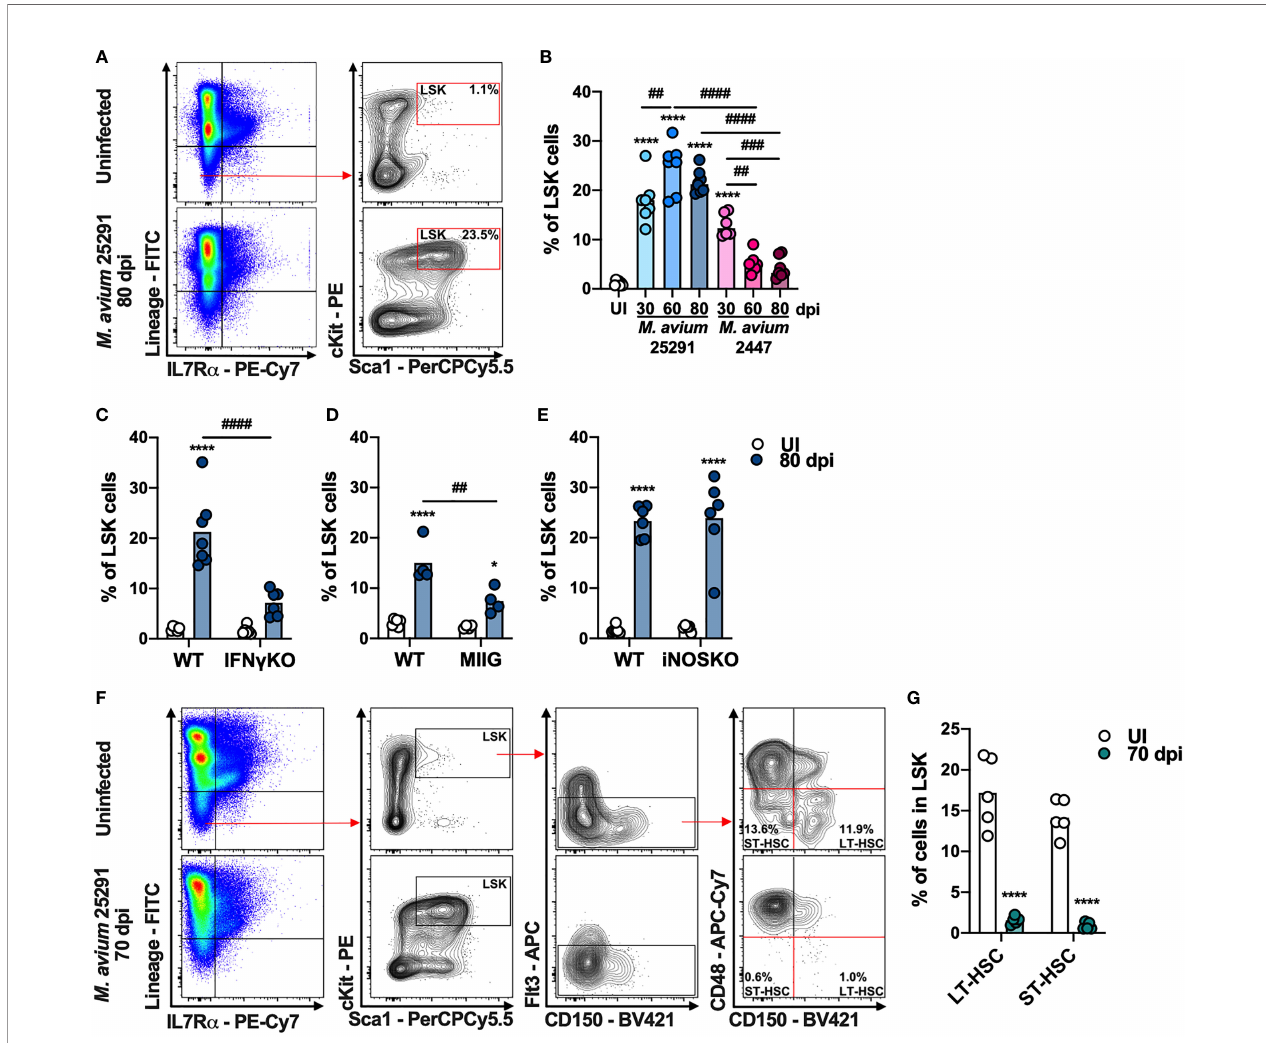
FIGURE 2 | Mice infected with M. avium strain 25291 have higher percentage of LSK cells in an IFN g -dependent and iNOS-independent manner. (A) Schematic representation of the gating used to identify LSK cell population in the BM from uninfected WT mice (top), or infected for 80 days with M. avium 25291 (bottom). Total BM cells were previously selected eliminating doublets and debris. (B) Percentage of LSK cells from uninfected WT mice (white) or after infection with M. avium strain 25291 (blue) or strain 2447 (pink) at 30, 60 and 80 dpi. Comparisons between infected and uninfected mice were performed using ordinary one-way ANOVA followed by Dunnett ’ s multiple comparisons test, and marked as: **** p < 0.0001; comparisons between all the infected groups were performed using a 2-way ANOVA followed by Tukey ’ s multiple comparisons test, and marked as: ## p < 0.01, ### p < 0.001, #### p < 0.0001. (C – E) Percentage of LSK cells from uninfected (white) or infected for 80 days with M. avium 25291 (blue) of WT, IFN g KO, MIIG or iNOSKO mice. Groups were compared using 2-way ANOVA followed by Tukey ’ s multiple comparisons test; statistical differences between uninfected and infected mice were marked as * p < 0.05 and **** p < 0.0001; and between infected groups as ## p < 0.01, #### p < 0.0001. (F) Schematic representation of the gating used to identify LT-HSC and ST-HSC cell populations in the BM from uninfected WT mice (top), or infected for 70 days with M. avium 25291 (bottom) (G) Percentage of LT-HSC and ST-HSC cells in WT uninfected (white) or after 70 days of infection